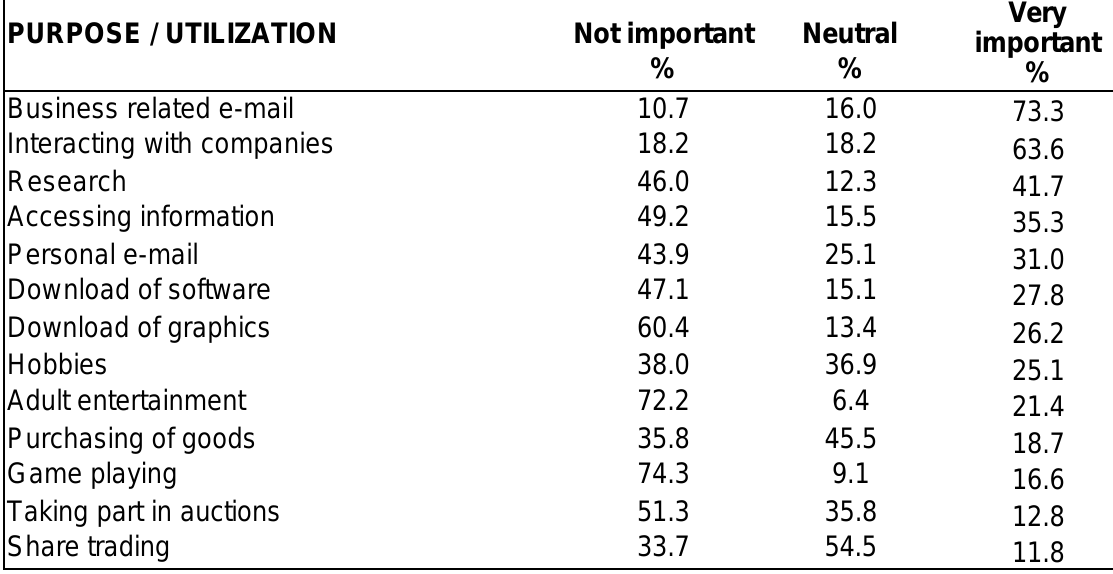
TABLE 2: IMPORTANCE OF THE